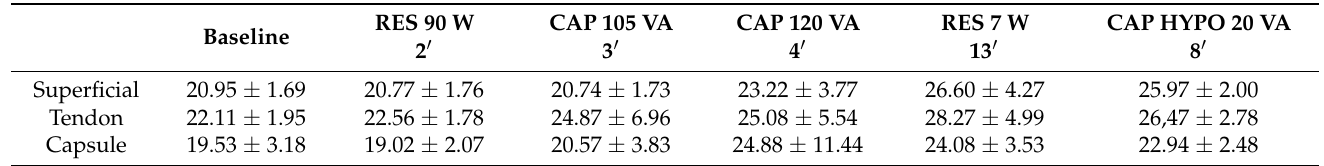
Table 1. Descriptive outcomes of the superficial, common extensor tendon (tendon), and radiohumeral capsule (capsule) temperatures.